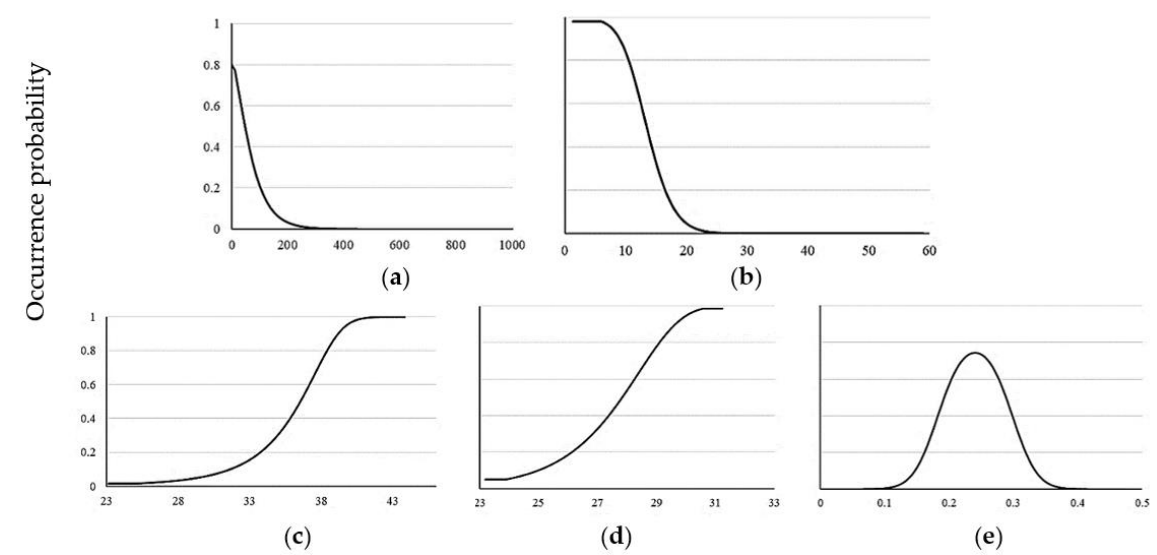
Figure 4. Response curves of the environmental variables showing occurrence probability for Pha- lacrocorax nigrogularis . ( a ) Depth (sea floor depth, m), ( b ) MLD (mixed layer thickness, m), ( c ) SSS (sea surface salinity, ppt), ( d ) SST (sea surface temperature, °C), ( e ) SSH (sea surface height, m). The MESS analysis values ranged from − 44.22 to 55.89 (Figure 5a). The model extrap- olated most in the southern Red Sea, as it had negative values, indicating novelty in envi- ronmental space (i.e., outside the training range). The novelty was mostly driven by SST (Figure 5b). The areas around the Socotra archipelago were the least extrapolated (i.e., closer and inside the training range) within the predicted future distribution of the Socotra Cormorant (areas within the black polygon). The LF analyses indicated that MLD is the dominant limiting factor over the predicted current range (Figure 5c). Areas off the south- ern UAE coast had Depth as the limiting factor, while areas around Hawar Islands had SSS as the limiting factor. For the potential future distribution (Figure 5d), SSH was the limiting factor in almost the entire predicted future range. Areas near the Socotra archi- pelago showed MLD as the limiting factor.